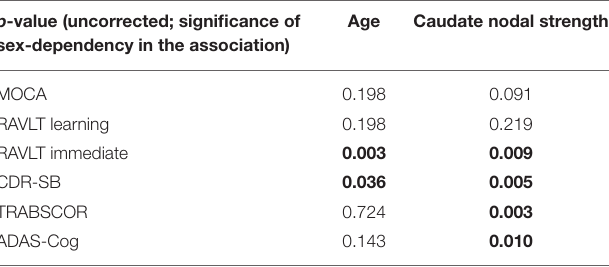
TABLE 2 | Significance of sex in the association between neuropsychological scores and age/caudate nodal strength. p -value (uncorrected; significance of sex-dependency in the